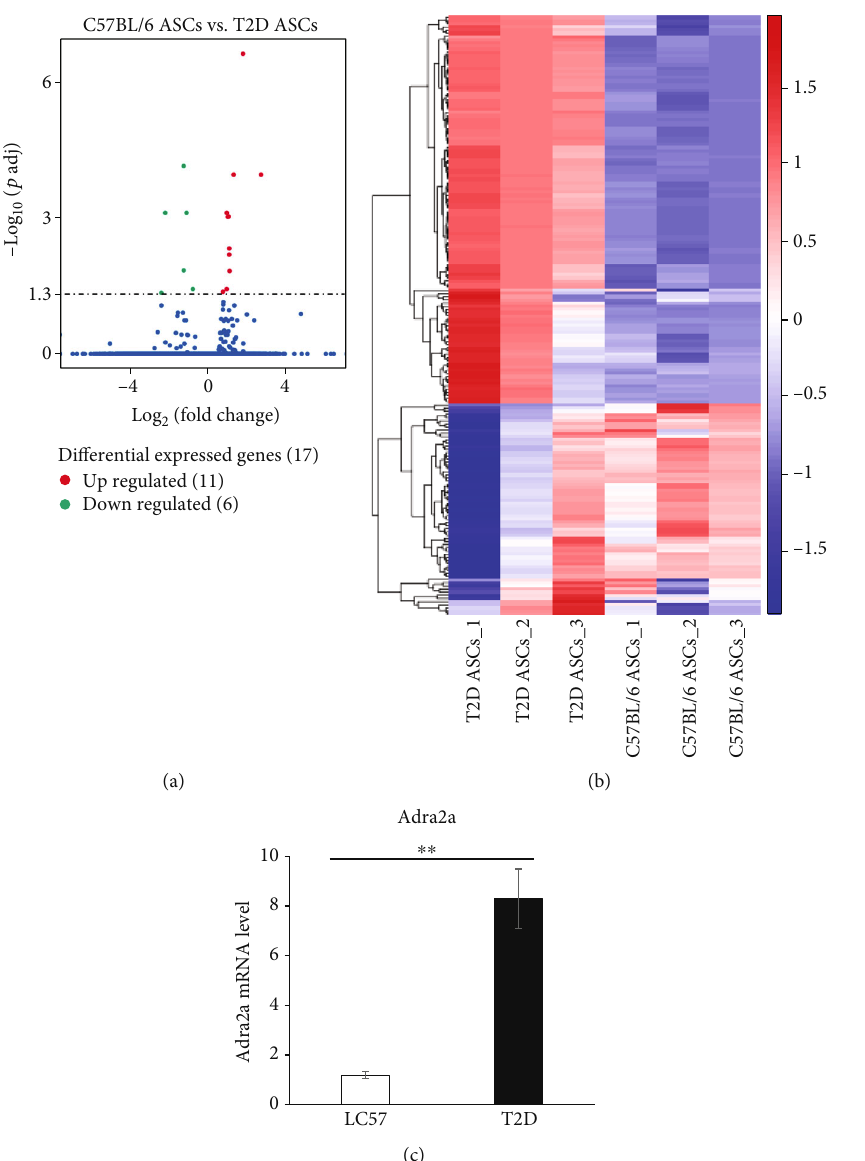
Figure 2: Transcriptomic pro fi les of C57BL/6 and T2D ASCs. (a) The volcano map shows the overall distribution of the di ff erential genes. Genes with signi fi cant di ff erential expression are indicated by red dots (upregulation) and green dots (downregulation). Genes with insigni fi cant di ff erential expression are represented by blue dots ( P < 0 : 05 ). (b) Heat map of gene expression in ASCs from chow mice ( n = 3 ) and T2D mice ( n = 3 ). Clustering shows twofold up- and down-regulated genes of ASCs. Red and blue represent upregulated and downregulated gene expression, respectively. (c) Expression of Adra2a gene of C57BL/6 and T2D ASCs tested by RT-PCR. ∗ P < 0 : 05 ; ∗∗ P < 0 : 01